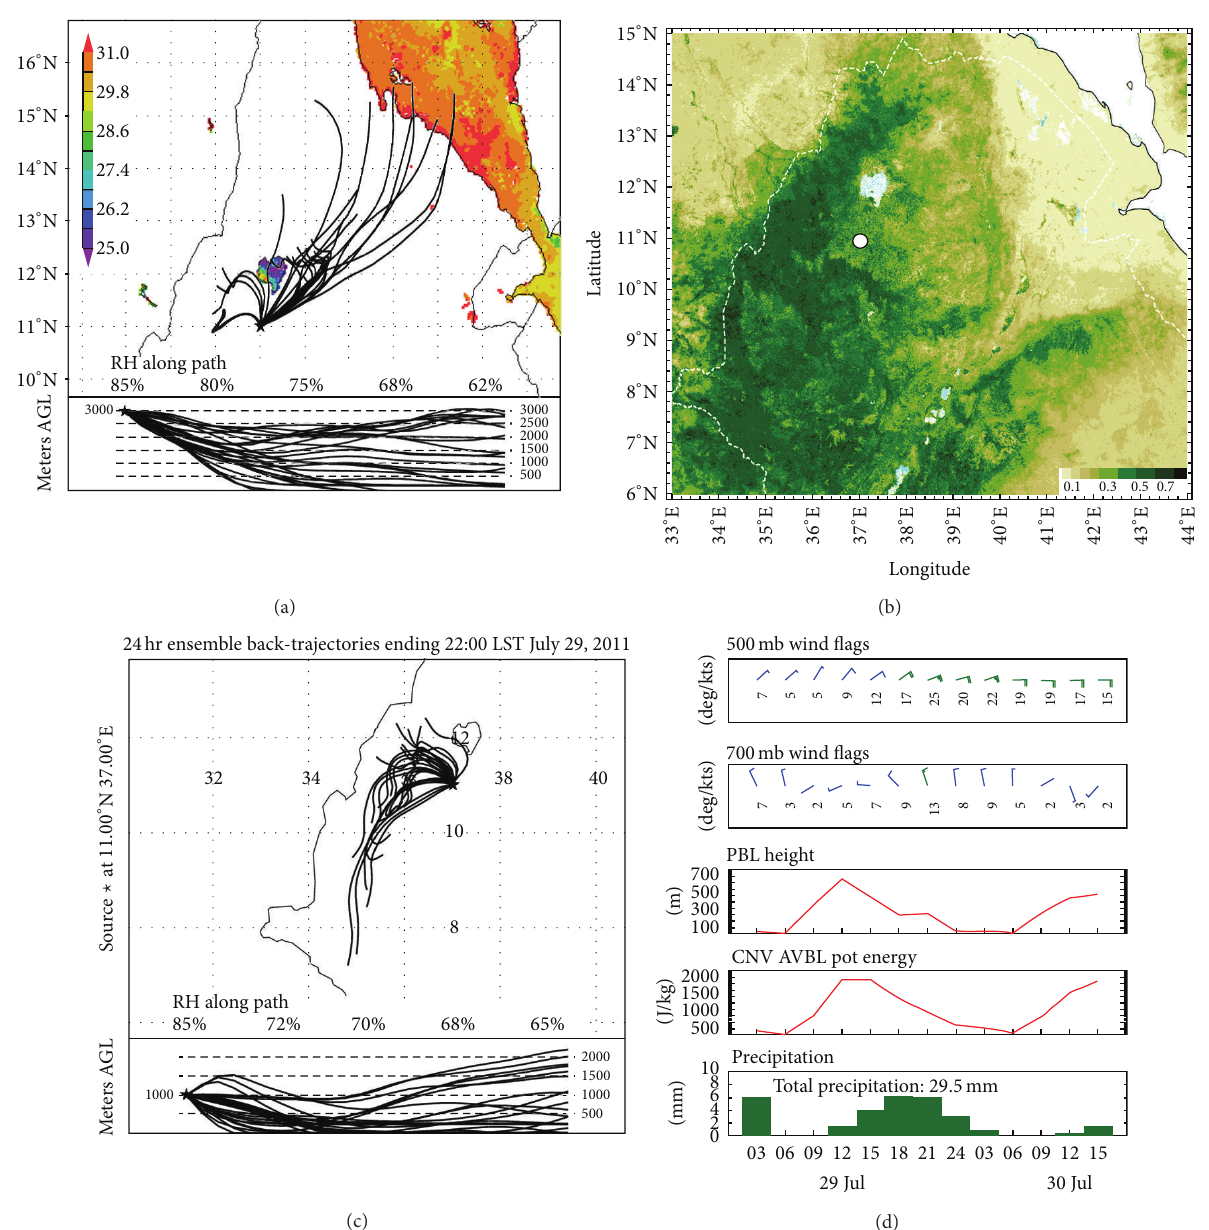
Figure 6: 24 hr ensemble back trajectories ending at 11 ∘ N, 37 ∘ E at 22:00 LST 29 July, 2011: (a) for 3000 m above ground with SST, (b) MODIS vegetation fraction during the period, (c) trajectories ending 1000m above ground, and (d) GFS meteogram of winds, PBL height,